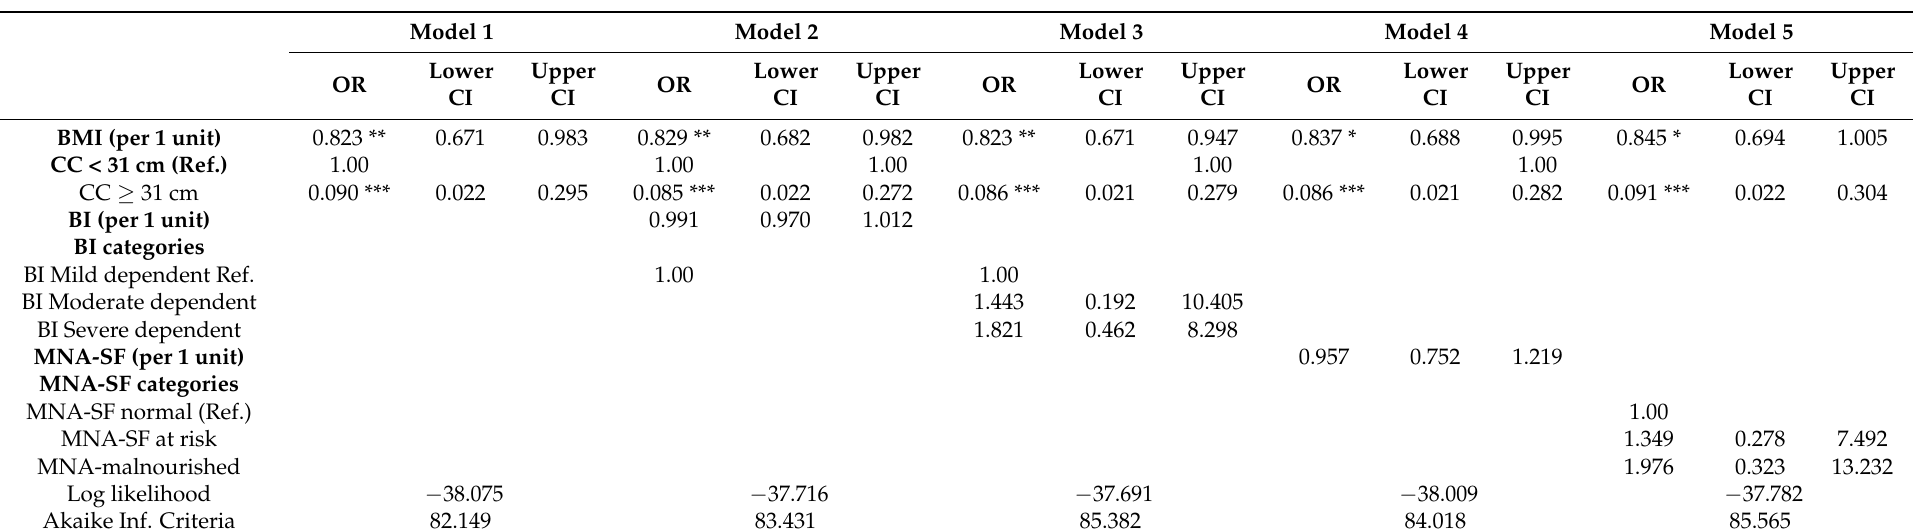
Table 4. Factors associated with sarcopenia according to multivariable logistic regression